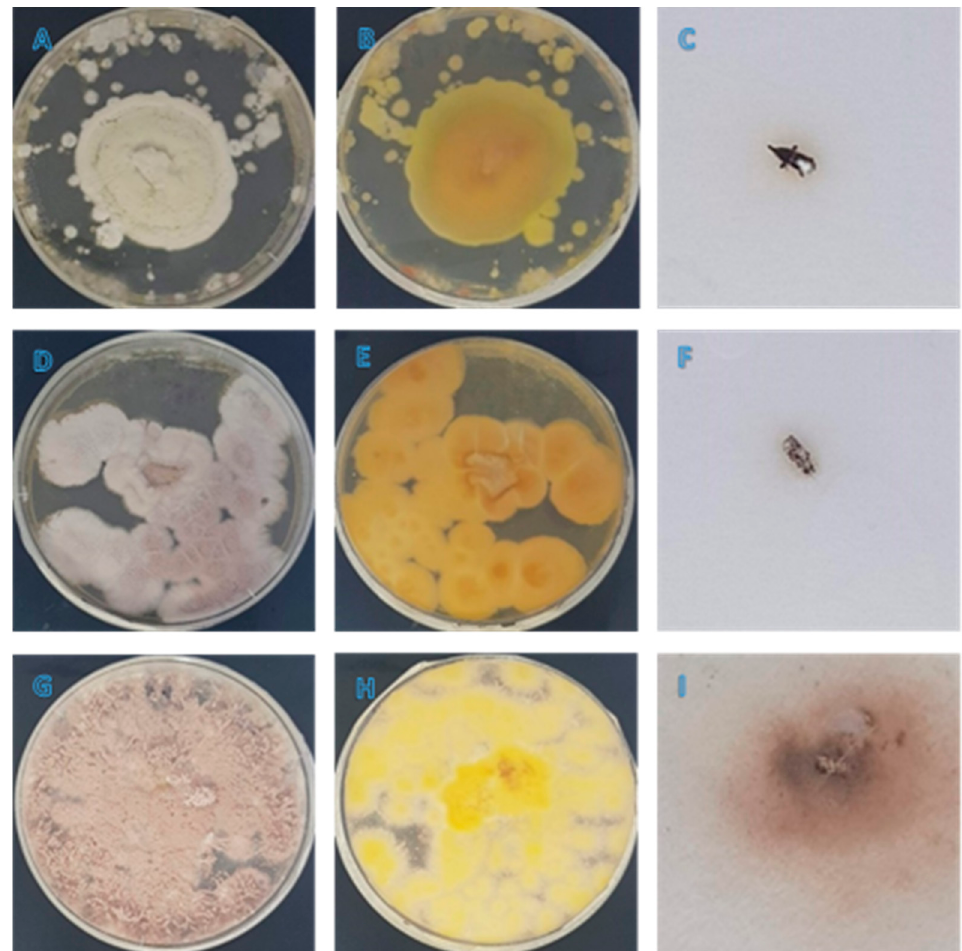
Figure 2. Cultures of EPF species examined during the present study: B. varroae colony top ( A ) and bottom ( B ), B. varroae infecting S. zeamais . ( C ). P. lavendulum colony top ( D ) and bottom ( E ), P. lavendulum infecting S. zeamais . ( F ). C. blackwelliae colony top ( G ) and bottom ( H ), C. blackwelliae infecting S. zeamais ( I